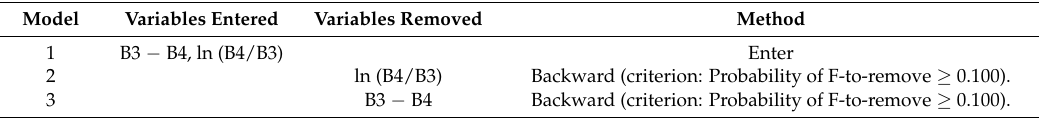
Table 7. Variables entered/removed from TP predictive models depending on the regression method used.